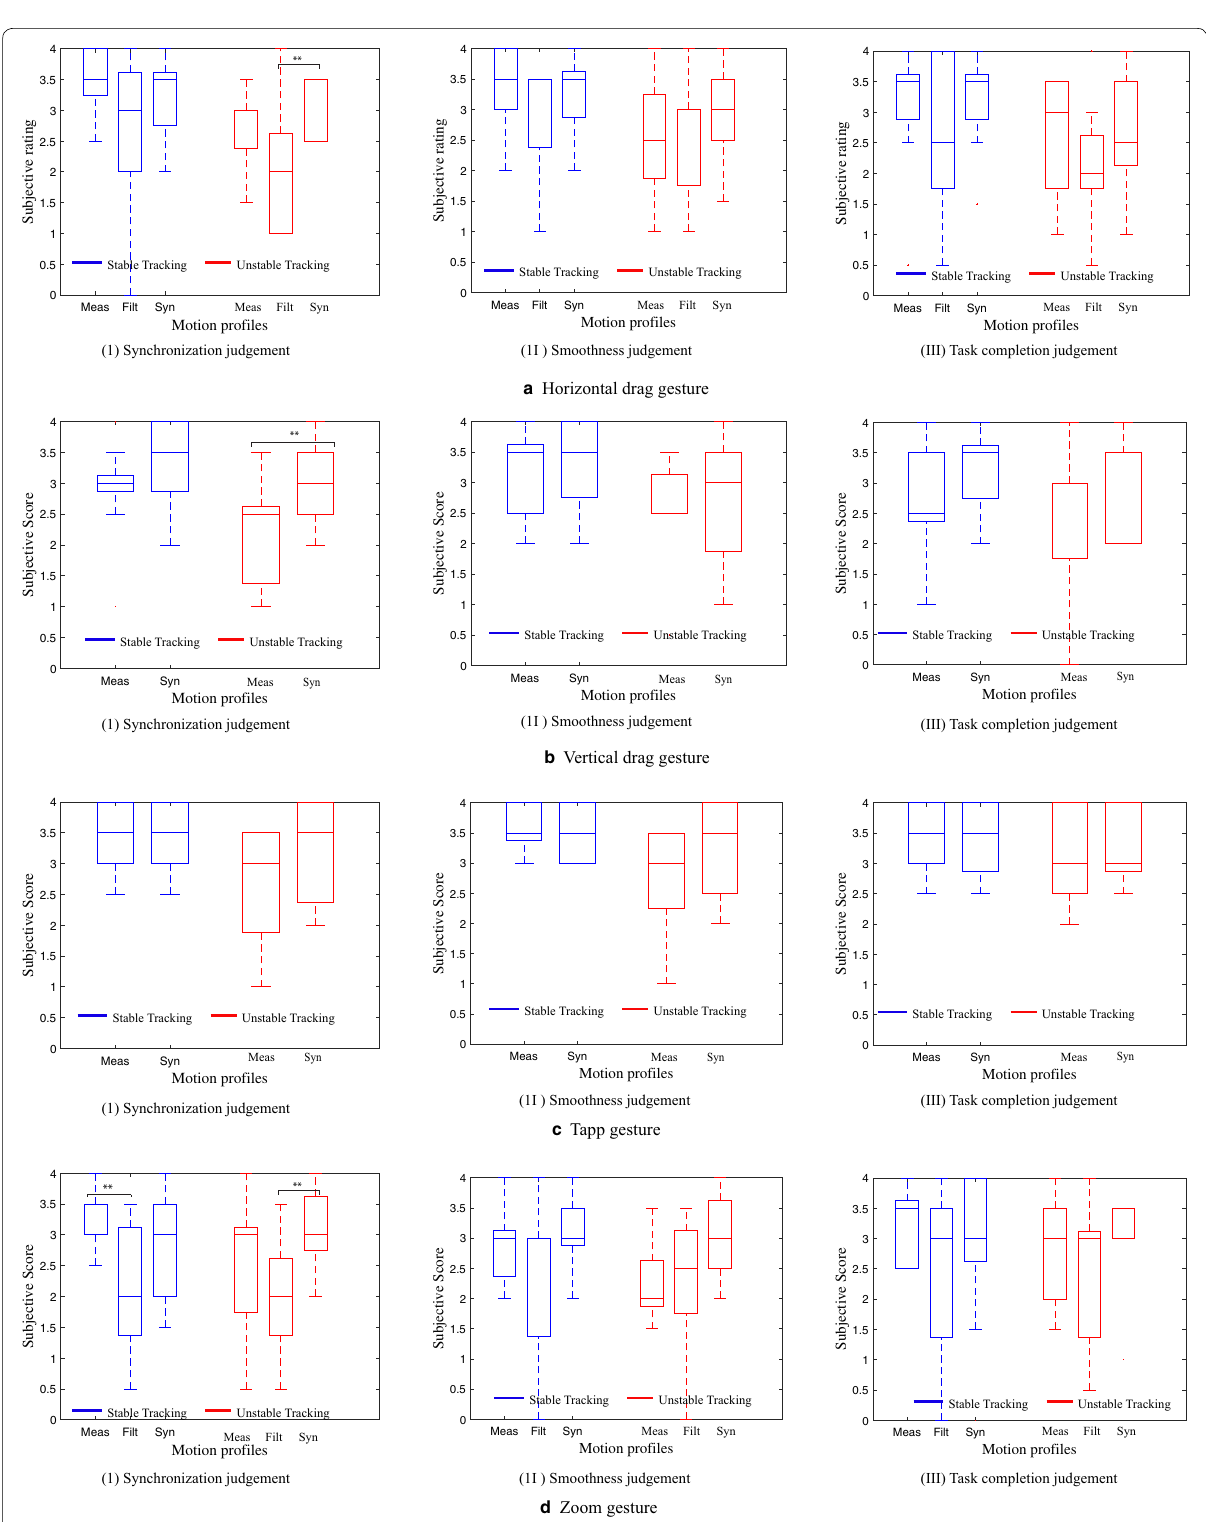
Fig. 8 Subjective evaluation results. Subjective evaluation results of the three judgement questions for all subjects a Horizontal drag, b vertical drag, c tapping, d zooming. Here the Meas corresponds to measured motion data, Syn synthesized motion and filt filtered motion data respectively. (** p < 0.001 and * p < 0.05. Adjustment for multiple comparisons: